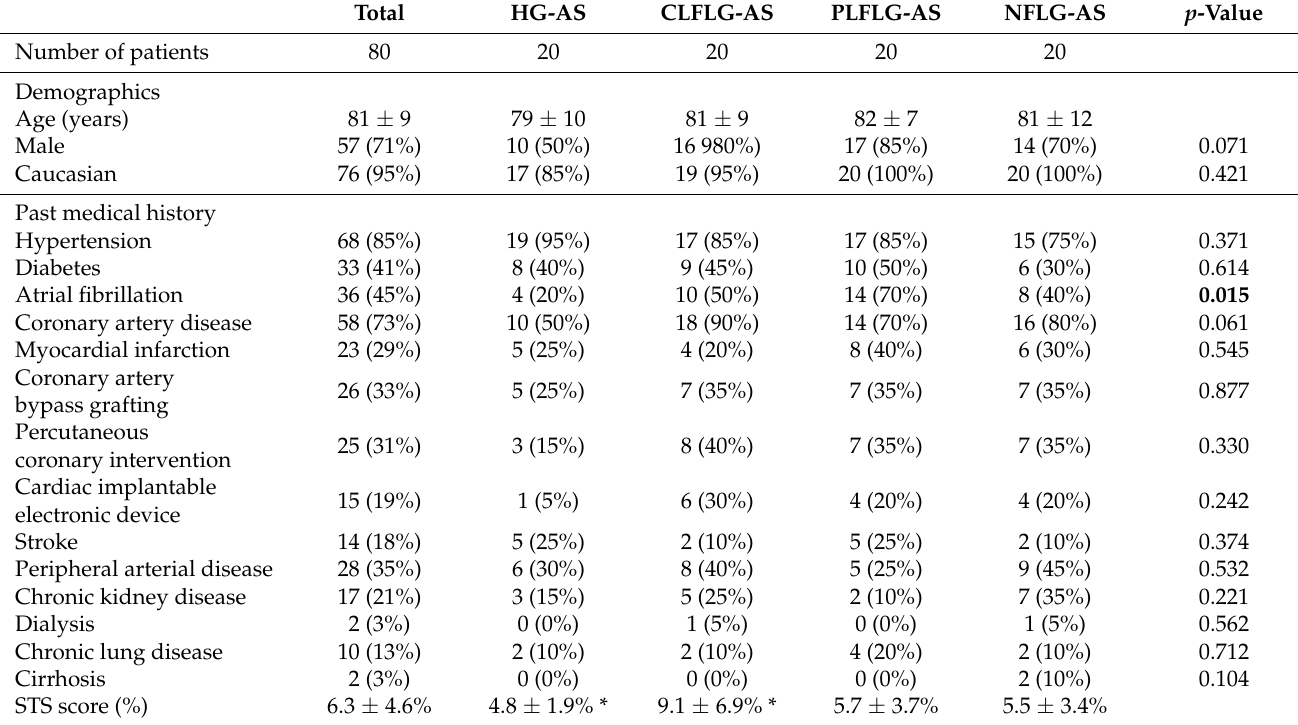
Table 1. Clinical characteristics of the cohort and aortic stenosis subgroup. Total HG-AS CLFLG-AS